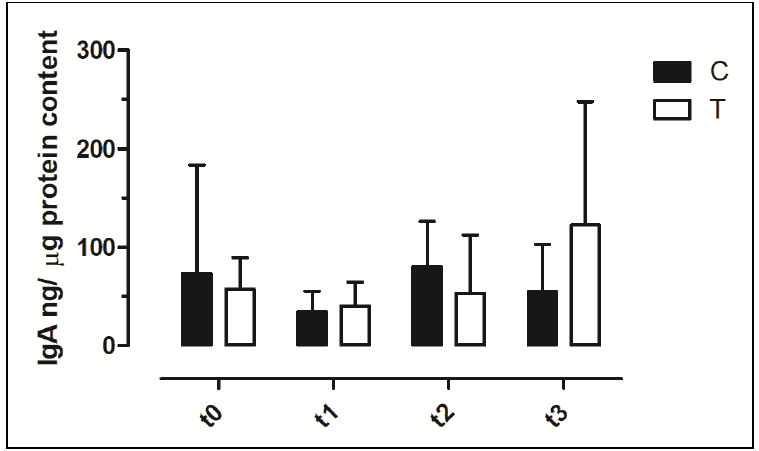
Figure 5. Concentration of Immunoglobulin A (IgA) in faecal swabs. The data are reported as mean ± SD. T = supplemented hens ( n = 60); C = control hens ( n = 60); t0 = start of the trial; t1 = after 5 weeks of supplementation; t2 = end of supplementation; t3 = end of the trial.